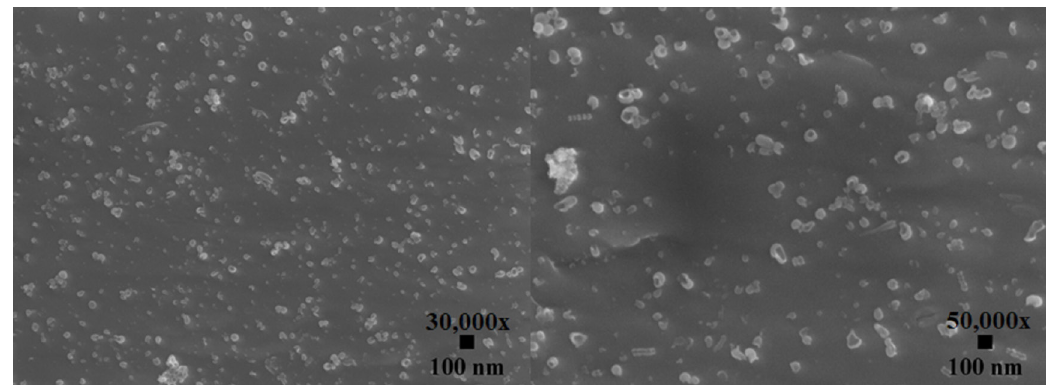
Figure 5. Nanostructures over the surface of anodized titanium with HCl at 15V with a concentration of 0.15M in 60 min.